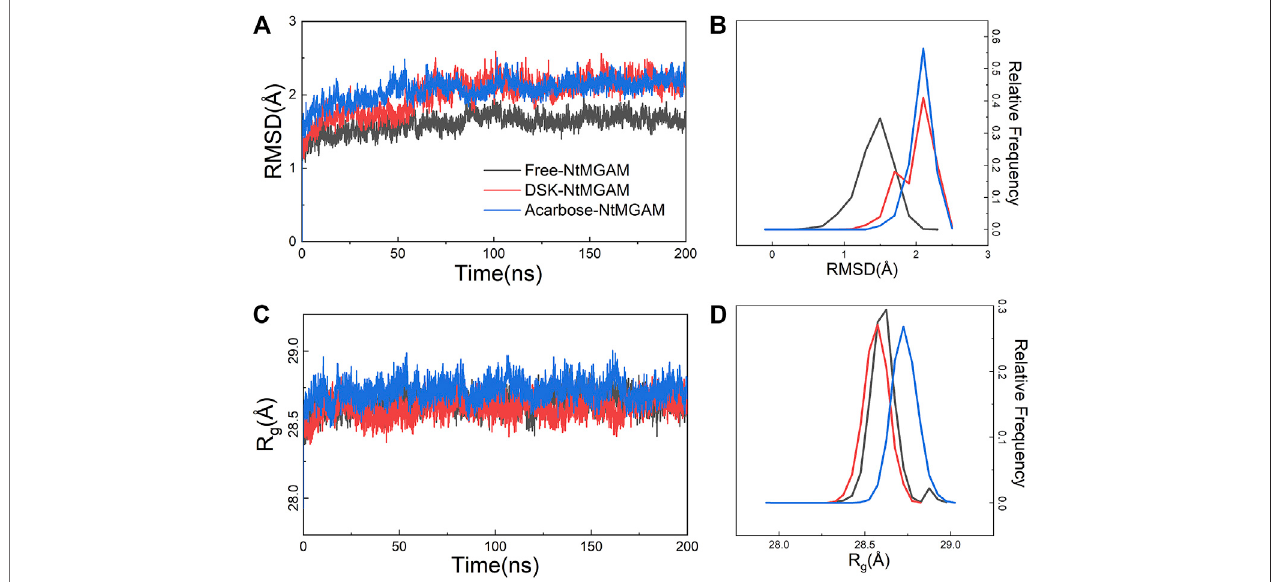
FIGURE 2 | Root-mean-square deviation (RMSD) and radius of gyration (R g ) analysis of NtMGAM with or without different ligands throughout 200 ns. (A) RMSD plot. (B) The relative frequency of the RMSD plot. (C) Gyration radius (R g ) plot. (D) The relative frequency of the R g plot.